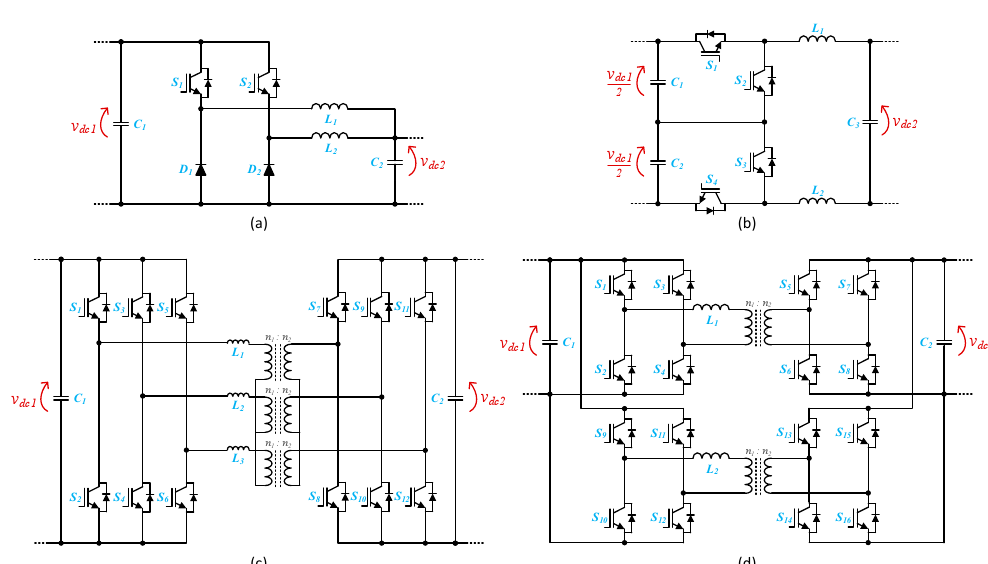
Figure 7. Main power electronics converters used as back-end power stage of off-board EVBC: ( a ) unidirectional interleaved buck-type; ( b ) bidirectional multilevel; ( c ) bidirectional three-phase isolated; ( d ) bidirectional multiple dual active bridge.